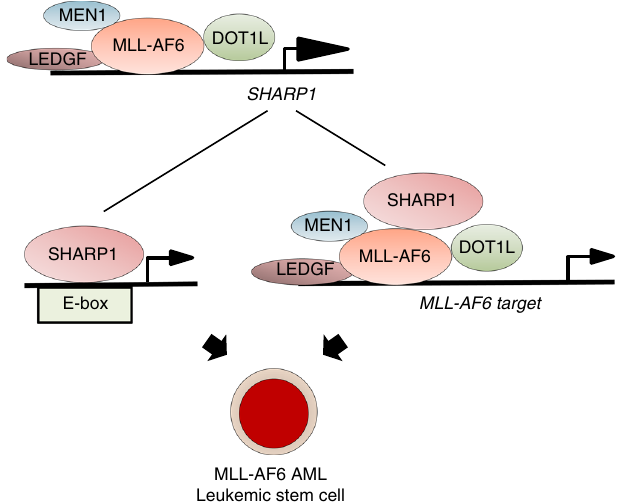
Fig. 8 Oncogenic role for SHARP1 in MLL-AF6 AML MLL-AF6 protein binds to and activates the SHARP1 gene in a DOT1L-dependent